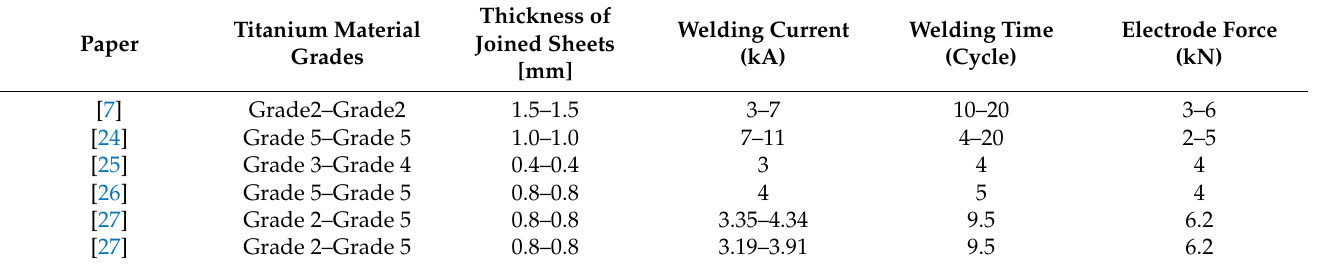
Table 1. List of works on resistance spot welding of titanium and titanium